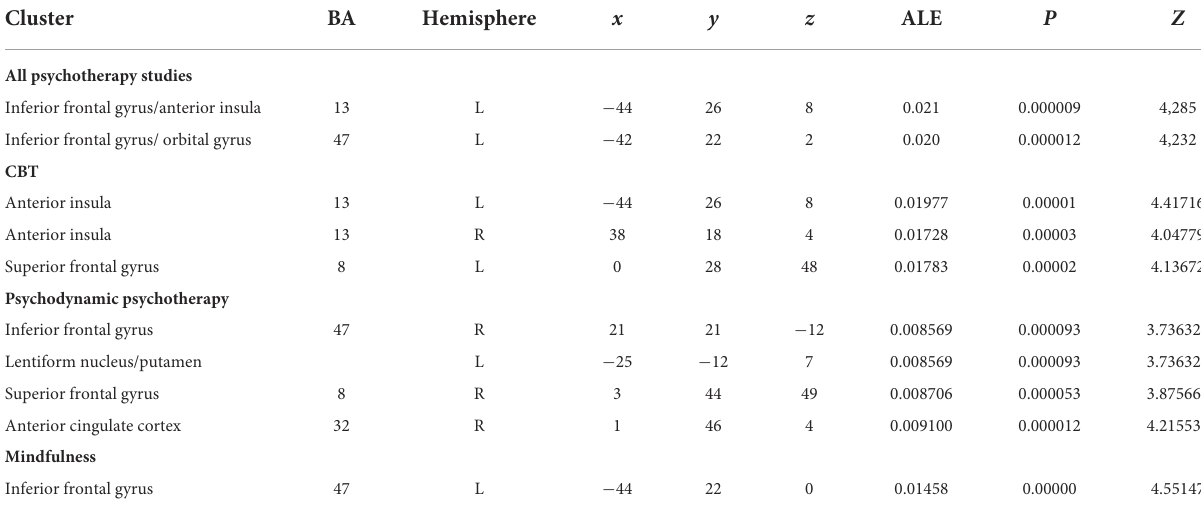
TABLE 2 Brain clusters resulting from ALE meta-analysis performed for all psychotherapy, CBT, PDT, and mindfulness based studies. Cluster BA Hemisphere